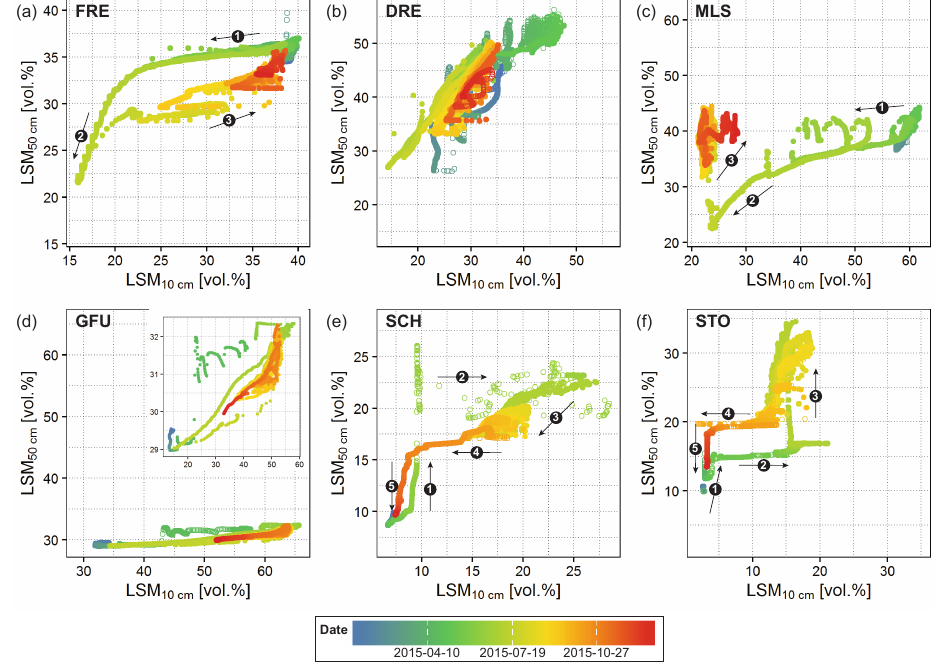
Figure 8. Moisture orbit at each SOMOMOUNT station from the 1 January to the 31 December 2015. The numbered arrows indicate the most important stages at each station as well as the sense of the evolution. The hollow circles represent LSM measurements taken when the temperature was below 1 ◦ C at